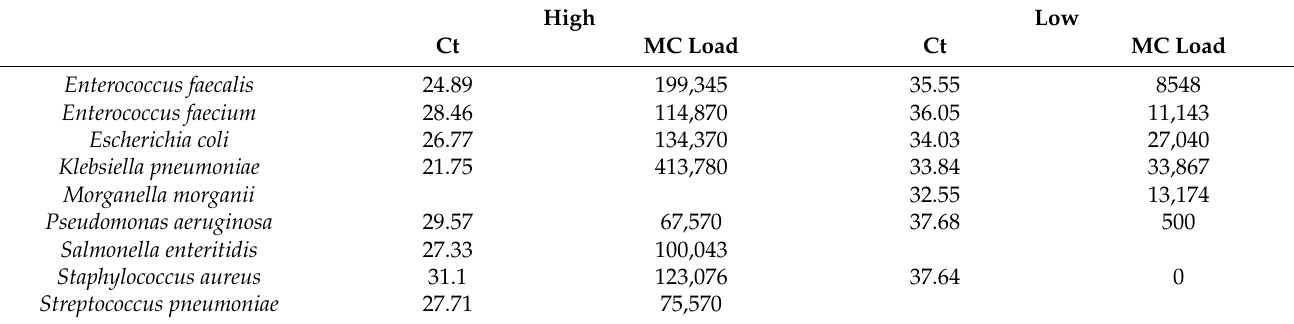
Figure 2. Comparison of DNA extraction with (P) or without (N) Polaris pre-treatment. The test was performed on three replicates on three different bacterial species, Staphylococcus haemolyticus (Sh), Proteus mirabilis (Pm) and Escherichia coli (Ec). Molecular Culture loads are expressed in Relative Fluorescence Units (RFU). Adding Polaris pre-treatment resulted in significantly increased detected loads. Table 1. Detection of different bacterial species via molecular culture (MC) with either a high (Ct < 30) or a low (Ct > 30) load isolated from blood with Polaris pre-treatment. MC loads are expressed in Log 2 Relative Fluorescence Units. High Low Ct MC Load